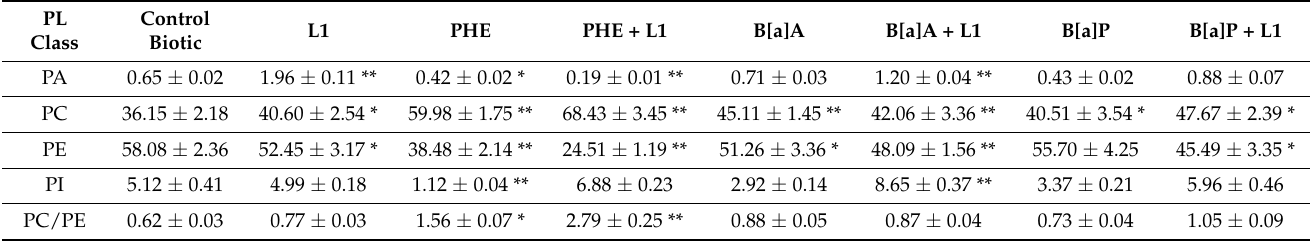
Table 3. The composition of phospholipids (PL) and PC/PE ratio determined in N. pironii cells after 24 h of cultivation with PHE, L1, or PHE + L1, or without the compounds tested. PA, phospha- tidic acid; PE, phosphatidylethanolamine; PC, phosphatidylcholine; PG, phosphatidylglycerol; PI, phosphatidylinositol; PS, phosphatidylserine. Data represent mean ± SE. * p ≤ 0.05, ** p ≤